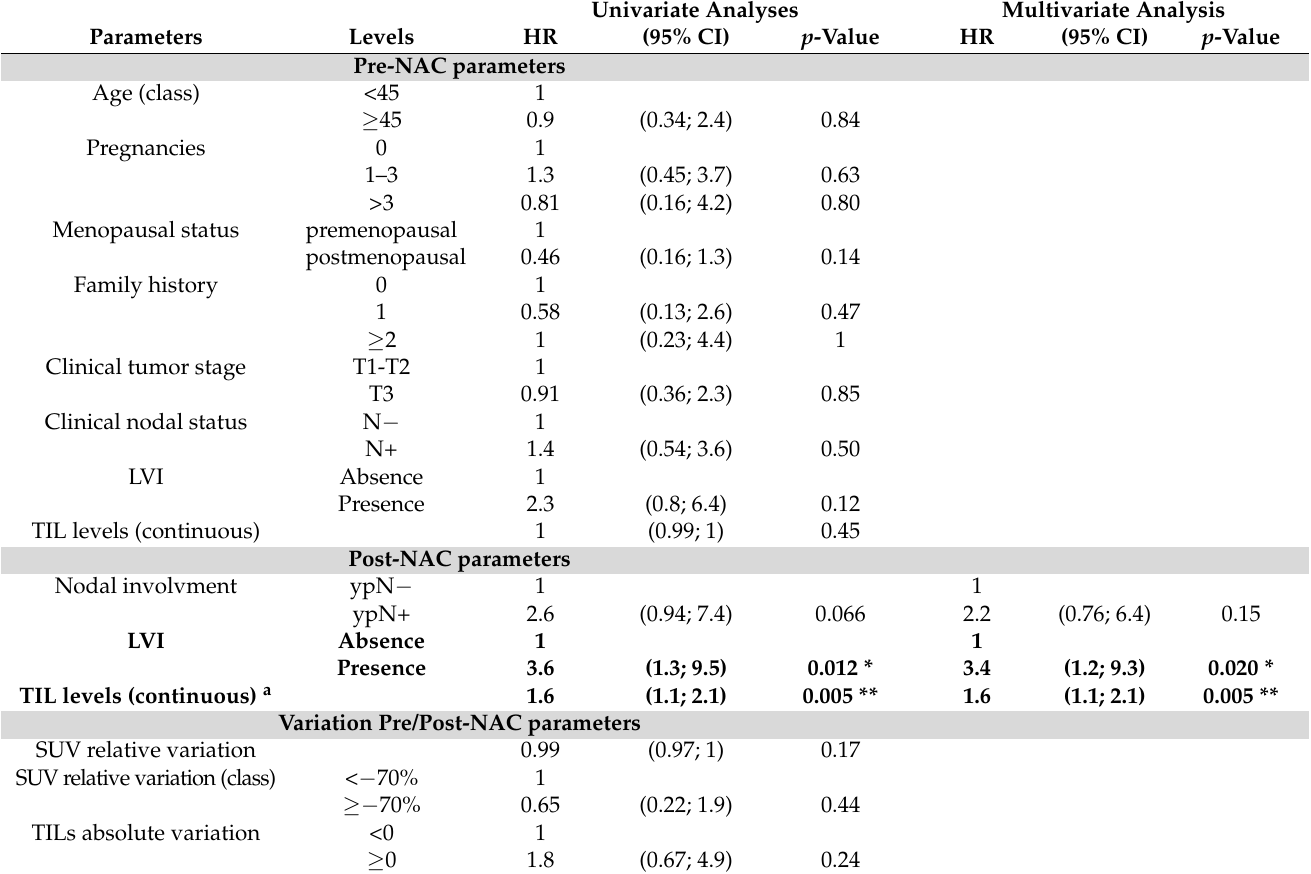
Table 4. Predictive factors associated with RFS for the Non-pCR subcohort. Univariate Analyses Multivariate